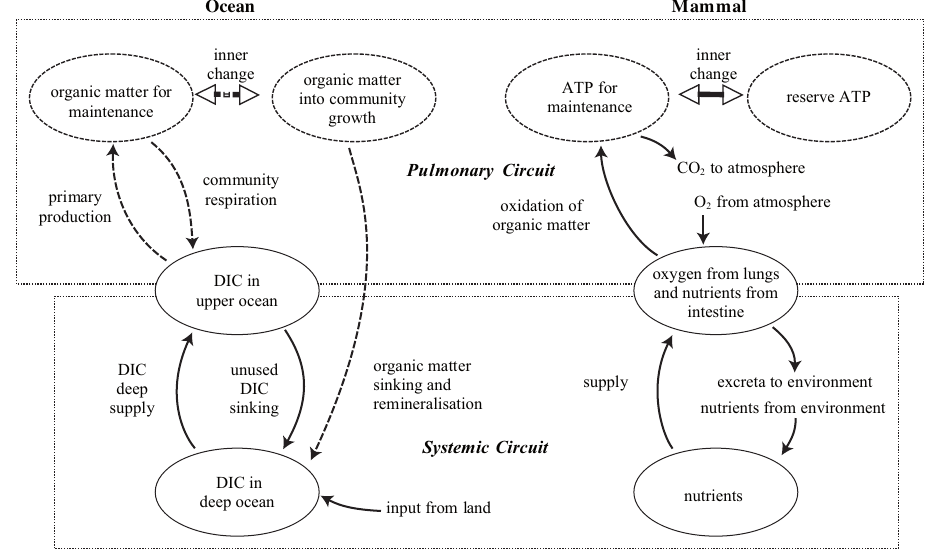
Fig . 4. – schematics of the fluxes (arrows) and reservoirs (ellipses) of energy for mammals (right) and the ocean (left), drawn to emphasise the similar energy-transformation patterns in mammals and the earth system. The former are open systems that exchange gases and nutrients with the environment, while the earth may be thought as a closed system with no net carbon input/output. For the earth energy fluxes are expressed as carbon fluxes: solid arrows represent fluxes of inorganic carbon and dashed arrows indicate conversion between inorganic and organic forms. For both ocean and mammals the metabolic rate is the temporal rate of change of the maintenance reservoir, in the case of the upper ocean given by Mr = pp – nCp. abbreviations are as in Table